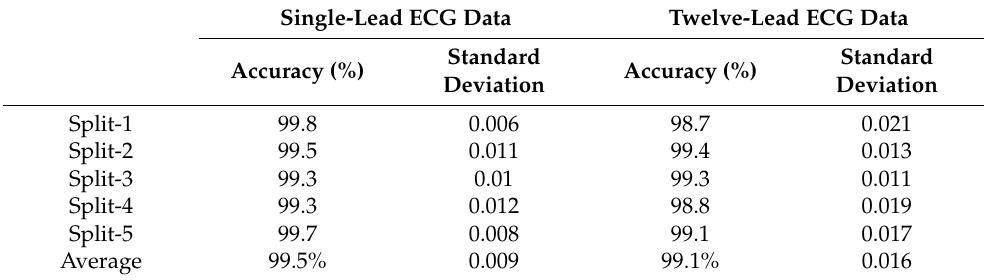
Table 6. Accuracies of the k-fold cross validation.